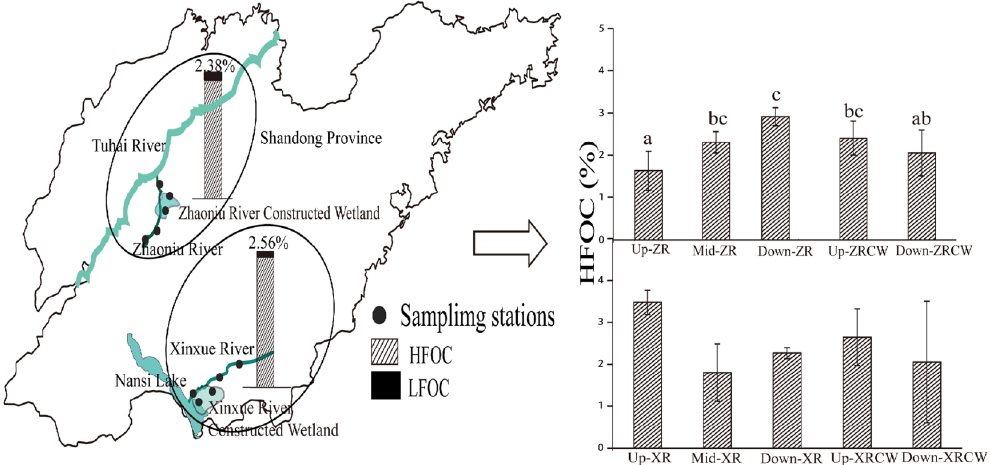
Figure 1. Sampling areas and C contents in Shandong Province (HFOC: heavy fraction organic carbon. LFOC: light fraction organic carbon). Up/Mid/Down-ZR: upstream/midstream/downstream of Zhaoniu River. Up/Down-ZRCW: upstream/downstream of Zhaoniu River Constructed Wetland. Up/Mid/Down-XR: upstream/midstream/downstream of Xinxue River. Up/Down-XRCW: upstream/downstream of Xinxue River Constructed Wetland. Bars sharing the same lowercase letter (a or b) are not significant at α = 0.05 (Duncan test). XR and XRCW, ZR and ZRCW are circled into two zones, respectively. (Software of Adobe Illustrator CS 6, OriginPro 9.0, ArcGIS 10.2, and Microsoft Excel were used in drawing the figure. The outline of Shandong Province was drawn by using ArcGIS (version 10.2) and referring to the map from http://map.ps123.net/ china/5369.html).